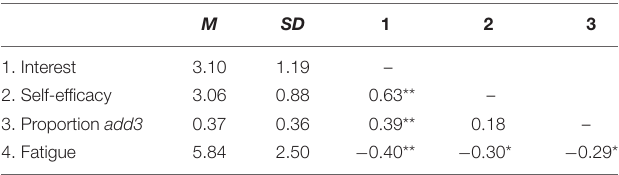
TABLE 1 | Descriptive statistics and correlations for Study